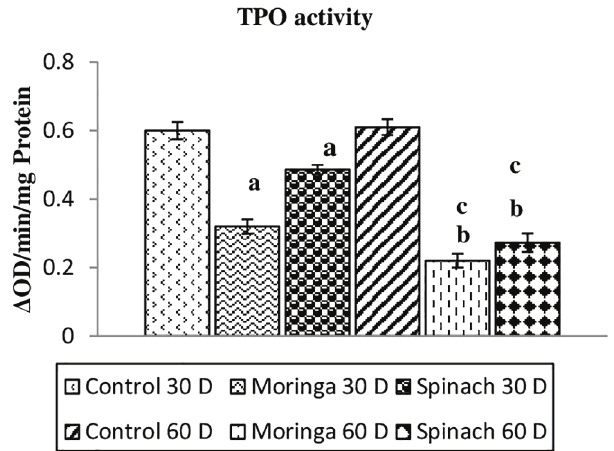
FIGURE 3 - Thyroid peroxidase (TPO) activity of selected plant foods treated animals for 30 days and 60 days respectively. Each pool contained a mixture of three thyroid glands isolated from three individual rats. One-way analysis of variance (ANOVA) test followed by Tukey’s post hoc test was done to determine differences across means of different groups. Mean values are significantle different by ANOVA at p<0.05. a Control 30 days versus treated 30 days group; b Control 60 days versus treated 60 days group; c Treated 30 days versus treated 60 days group.